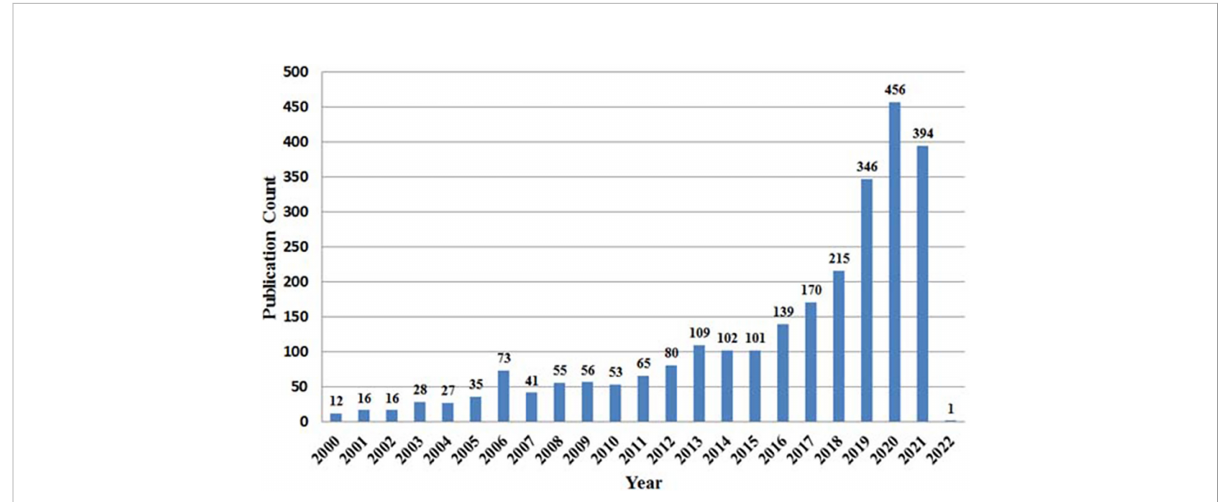
FIGURE 2 Yearly Publication of AI application in breast cancer diagnosis and prognosis